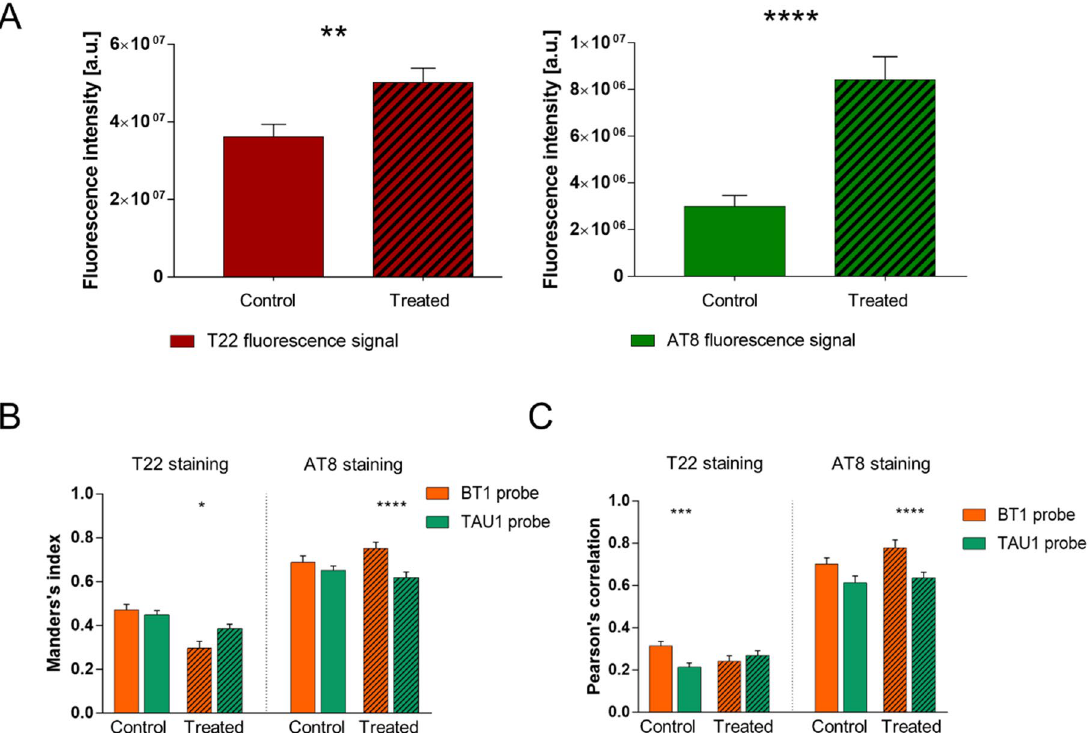
Figure 6. BT1 binds to hyperphosphorylated and oligomeric tau in OA treated neurons. ( A ) Bar charts showing the fluorescence intensity quantification of (left) T22 signal (** p = 0.002, MW test; n = 53/3, fields of view/batches) and (right) AT8 signals (**** p < 0.0001, MW test; n = 53/6/3, fields of view/batches) in control condition and after the treatment with okadaic acid (50 nM) for 2 h. ( B ) Left , Manders’s colocalization in-dex of T22 staining with TAU1 (green) and BT1 (orange) fluo-rescence signal in control condition (p = 0.48, t-test; n = 25/3, fields of view/batches) and after the treatment with okadaic acid (50 nM) for 2 h (* p < 0.017, MW test; n = 25/3, fileds of view/batches). Right , Manders’s colocalization index of AT8 staining with TAU1 (green) and BT1 (orange) fluorescence signal in control condition ( p = 0.408, MW test; n = 25/3, fields of view/batches) and after the treatment with okadaic acid (50 nM) for 2 h (**** p < 0.0001, MW test; n = 25/3, fileds of view/ batches), as determined using the custom-made MATLAB code. ( C ) On the left, Pearson’s correlation index of T22 staining with TAU1 (green) and BT1 (orange) fluorescence signal in control condition (*** p = 0.0008, t-test; n = 25/3, fields of view/batches) and after the treatment with okadaic acid (50 nM) for 2 h ( p = 0.423, t-test; n = 25/3, fileds of view/batches). On the right, Pearson’s correlation index of AT8 staining with TAU1 (green) and BT1 (orange) fluorescence signal in control condition ( p = 0.056, MW test; n = 25/3, fields of view/batches) and after the treatment with okadaic acid (50 nM) for 2 h (**** p < 0.0001, MW test; n = 25/3, fileds of view/ batches), as determined using the custom-made MATLAB code. (Matlab software, version 2021a; URL: https:// it. mathw orks. com/ produ cts/ matlab. html?s_ tid= hp_ produ cts_